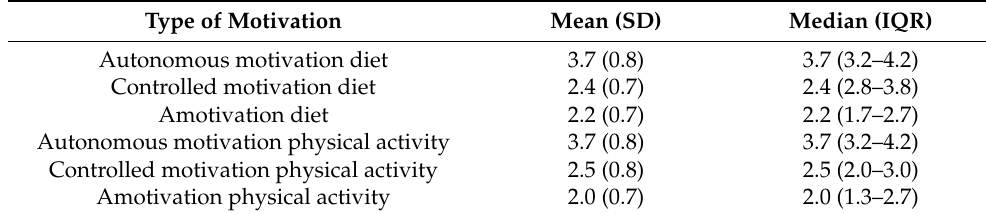
Table 3. Summary of means and standard deviations, median, and interquartile range for scores on different types of motivation for diet and physical